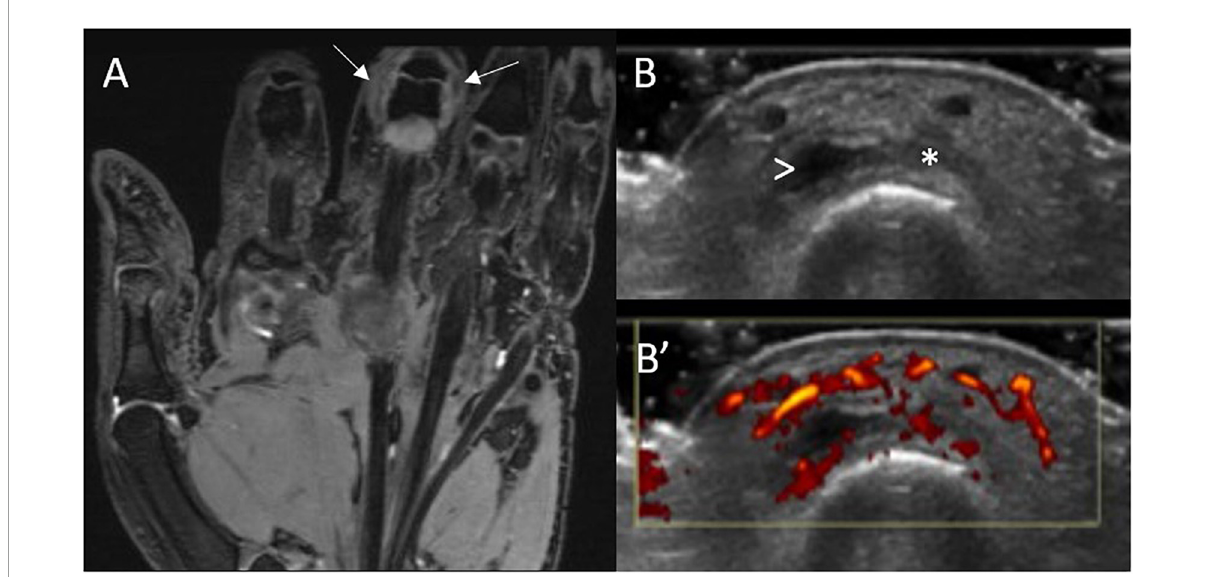
FIGURE3 MRI and US sub-clinical synovitis in a patient with CSA and high titre ACPA. MRI (A) synovitis (white arrows) of the 3rd PIP joint in an individual at-risk of RA with corresponding gray-scale (B) and power Doppler (B’) US scans. This individual had clinically suspect arthralgia and positive anti-CCP antibodies (high titre) and rheumatoid factor. These images were obtained 6 weeks before progression to RA. Asterisk indicates synovial hypertrophy, while the arrowhead a small joint effusion.